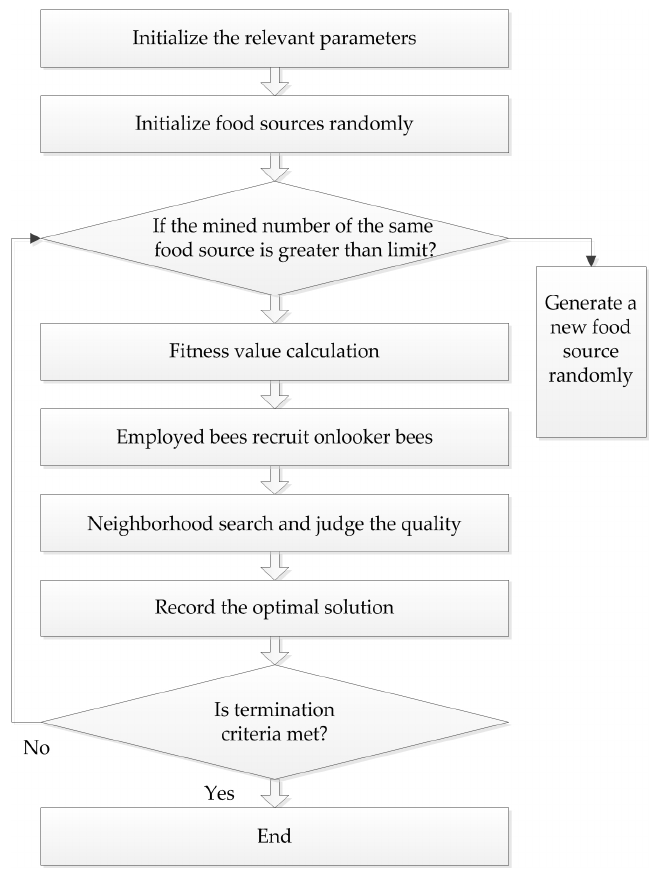
Figure 3. The flowchart of the ABC algorithm.